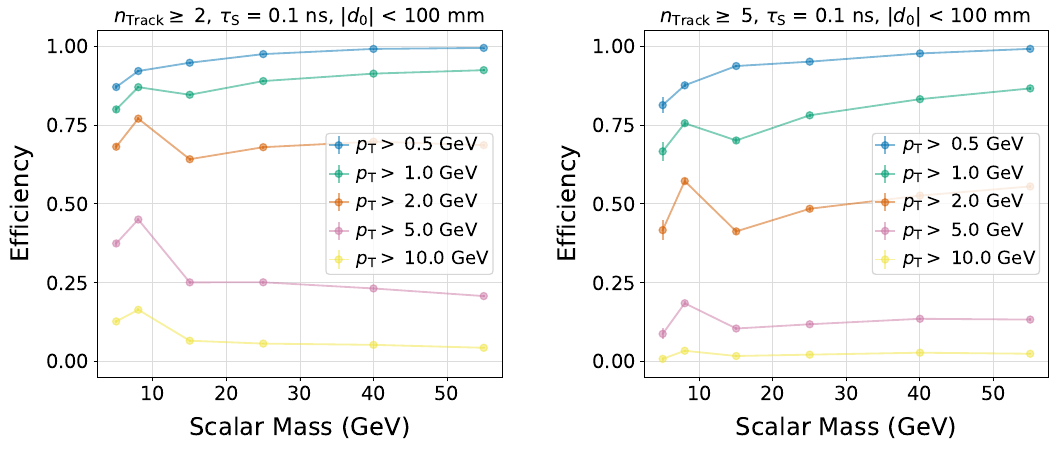
Figure 8. Event-level efficiency as a function of scalar mass for a range of minimum track p T values. Efficiencies are shown for the two (left) or five (right) scenarios. In all cases, the track reconstruction efficiency is assumed to decrease linearly with | d